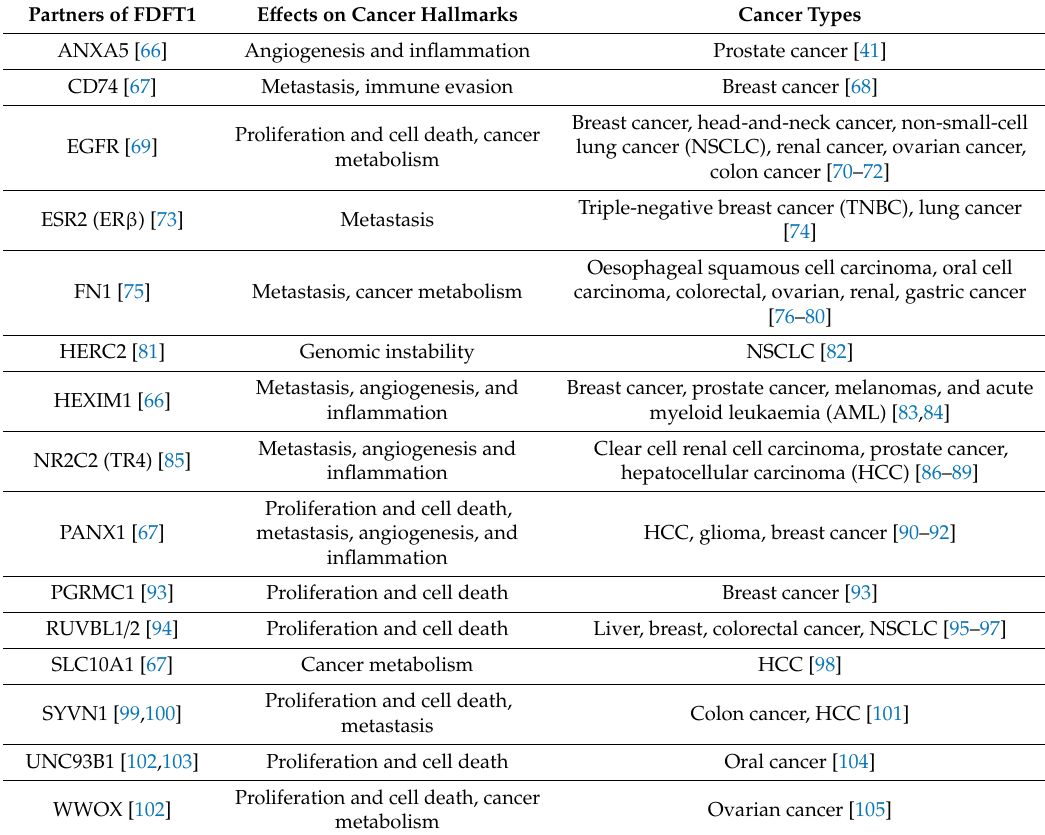
Table 1. Experimental evidence of interaction between FDFT1 and its